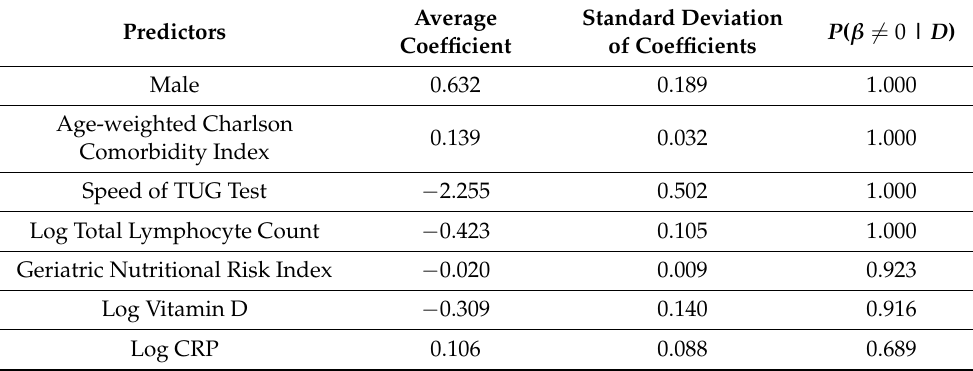
Table 2. Results from the iterated Bayesian model averaging of the multivariable Cox PH regressions. Posterior parameter estimates (averages), their standard deviations, and probabilities that coefficients are nonzero for the seven identified variables affecting mortality